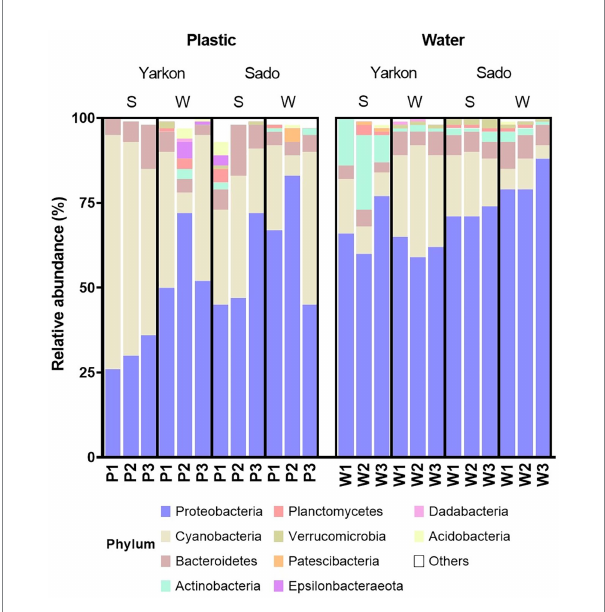
FIGURE 5 Relative abundances of the top 10 phyla in the microplastic and water samples from the Yarkon and Sado divided by seasons (S = summer, W = winter). P1-P3 represent repeats of the plastic samples, W1-W3 represent repeats of the water